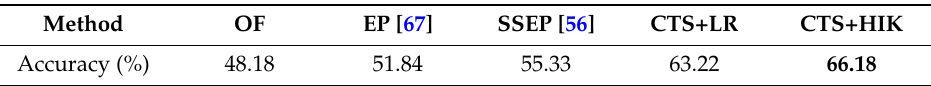
Figure 7. Classification result on the Scene-TZ Dataset. ( a ) A typical sample of each class in the 8-class Scene-TZ ( b ) Ground reference data ( c ) OF result ( d ) EP result ( e ) SSEP result ( f ) CTS result. Table 7. Classification accuracy comparison on Scene-TZ with ten training samples per class.